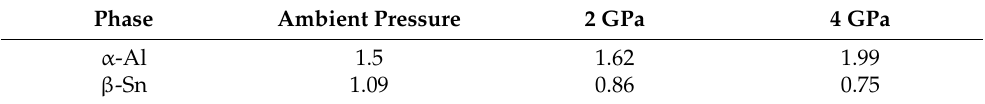
is due to the solid solution strengthening effect of each phase, the hardness of α -Al phase and β -Sn phase after being solidified under different pressure conditions were detected and demonstrated in Table 3. The results show that the hardness values of α -Al phase increase progressively with the increase of pressure, while, for β -Sn phase, it shows the opposite trend. Compared with the ambient pressure, the hardness values of α -Al phase at ambient pressure, 2 GPa and 4 GPa are 1.5 GPa, 1.62 GPa and 1.99 GPa, respectively. The hardness values of α -Al phase increase by 8% and 32.7%, respectively, at high pressure. The hardness of β -Sn phase at ambient pressure, 2 GPa and 4 GPa is 1.09 GPa, 0.86 GPa and 0.75 GPa, respectively. The hardness of β -Sn phase decreases by about 31.2% at 4 GPa. The stress–strain curves of α -Al phase calculated from the nano-hardness results solidification pressure. Table 3. The nano-hardness of α -Al and β -Sn phase solidified at different pressures.